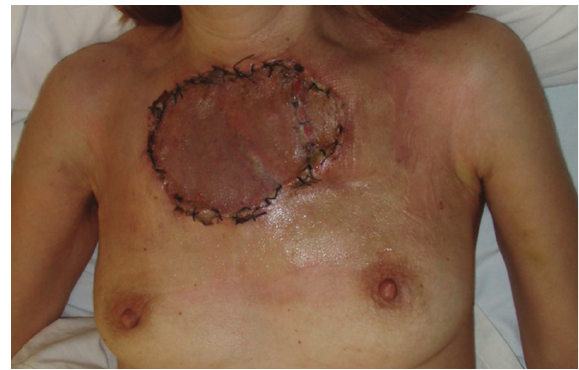
Figure 3: Immediate postoperative result after tumour resection and reconstruction with bilateral pectoralis major advancement flaps and split-thickness skin graft.